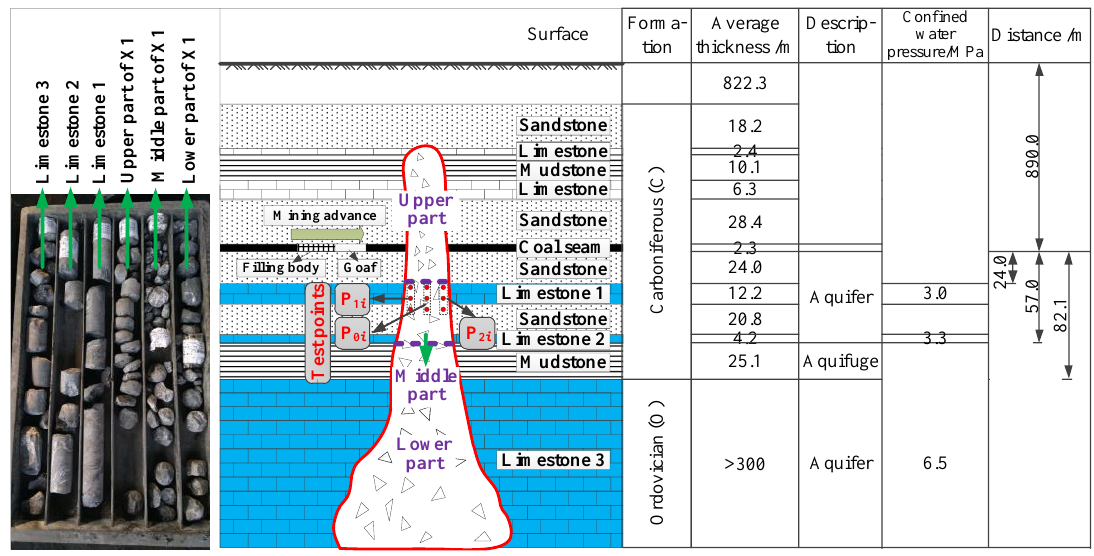
Figure 3. The profile and core of X1, and stratigraphic characteristics of surrounding rock.